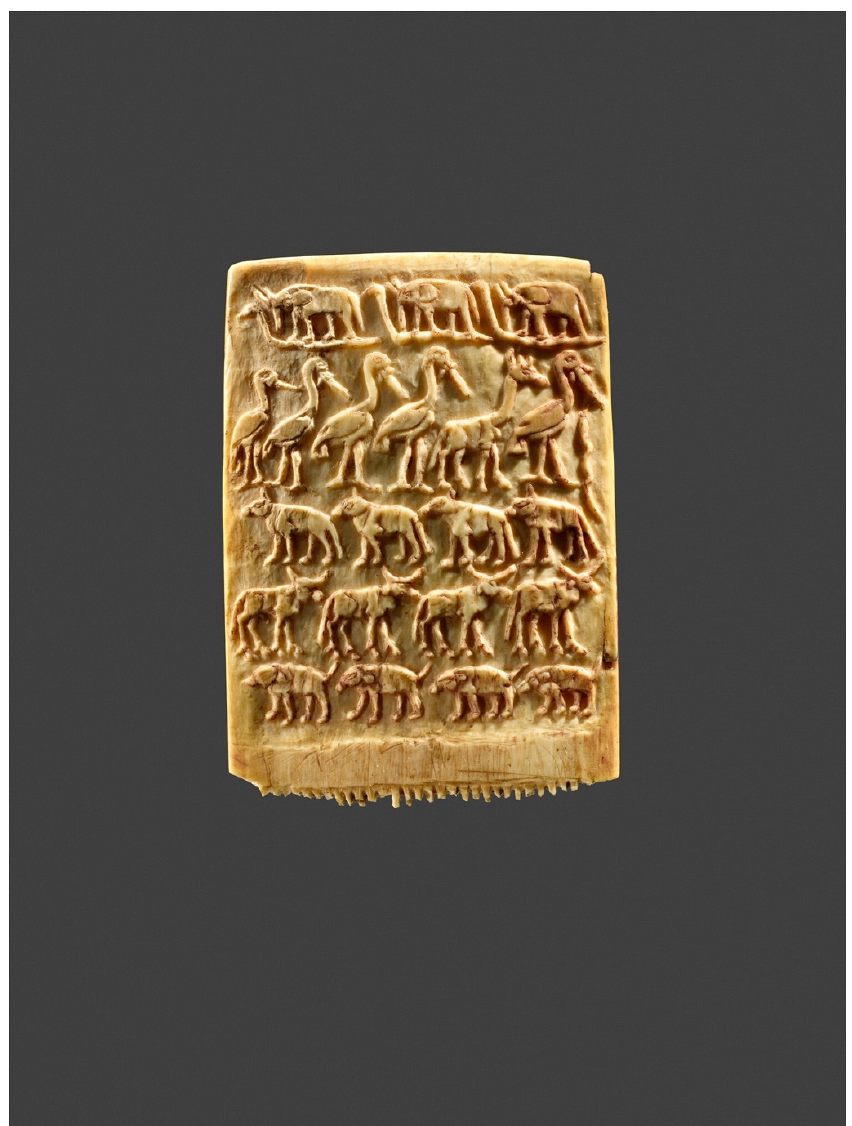
Figure 3. Hair Comb Decorated with Rows of Wild Animals, ivory, from Egypt, ca. 3200–3100 BCE. Theodore M. Davis Collection, bequest of Theodore M. Davis, 1915. Metropolitan Museum of Art, 30.8.224. Public